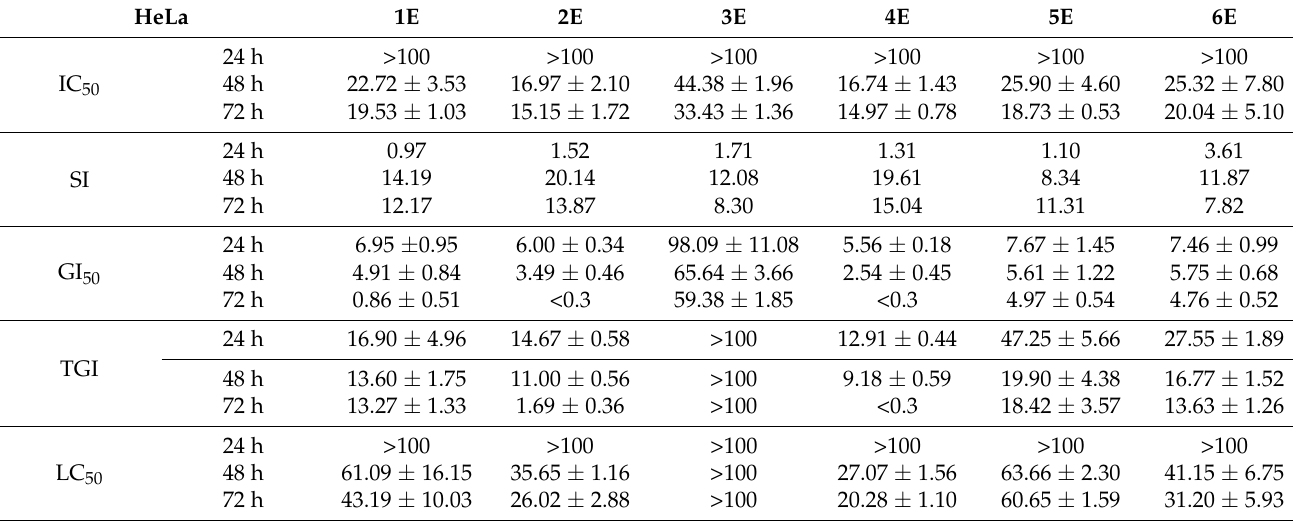
Table 6. Concentrations of extracts ( µ g/mL) that induce inhibition of biological activity in 50% cells (IC 50 ), 50% growth inhibition (GI 50 ), total growth inhibition (TGI) and 50% lethality (LC 50 ) in the HeLa cell line, expressed as X ± SD. SI: selectivity